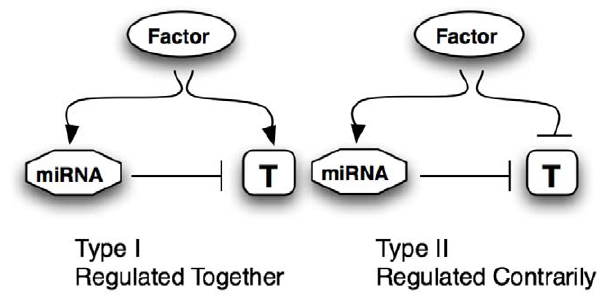
Figure 7. Two types of miRNA circuits in gene regulatory networks. In Type I, targets (T) are regulated together with the miRNA; or changes in expression would be correlated. In Type II, the upstream factor regulates the target and the miRNA contrarily, changes in expression would be anticorrelated. Reprinted from Molecular Cell, 26:5, Tsang, Zhu, and van Oudenaarden, ‘‘MicroRNA-Mediated Feedback and Feedforward Loops are Recurrent Network Motifs in Mammals,’’ Copyright (2007), with permission from Elsevier.